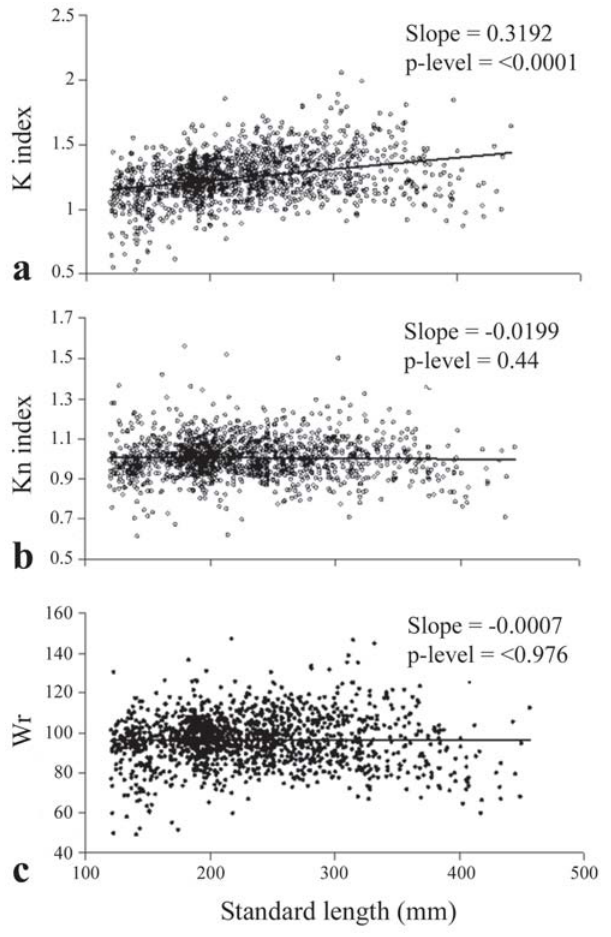
Fig. 2. Relationship between standard length and (a) K index, (b) Kn index and (c) Wr index for pejerrey populations in